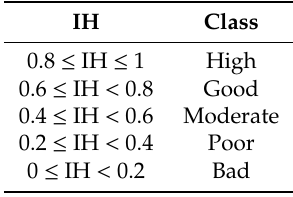
Table 1. Habitat integrity classes according to the IH index.